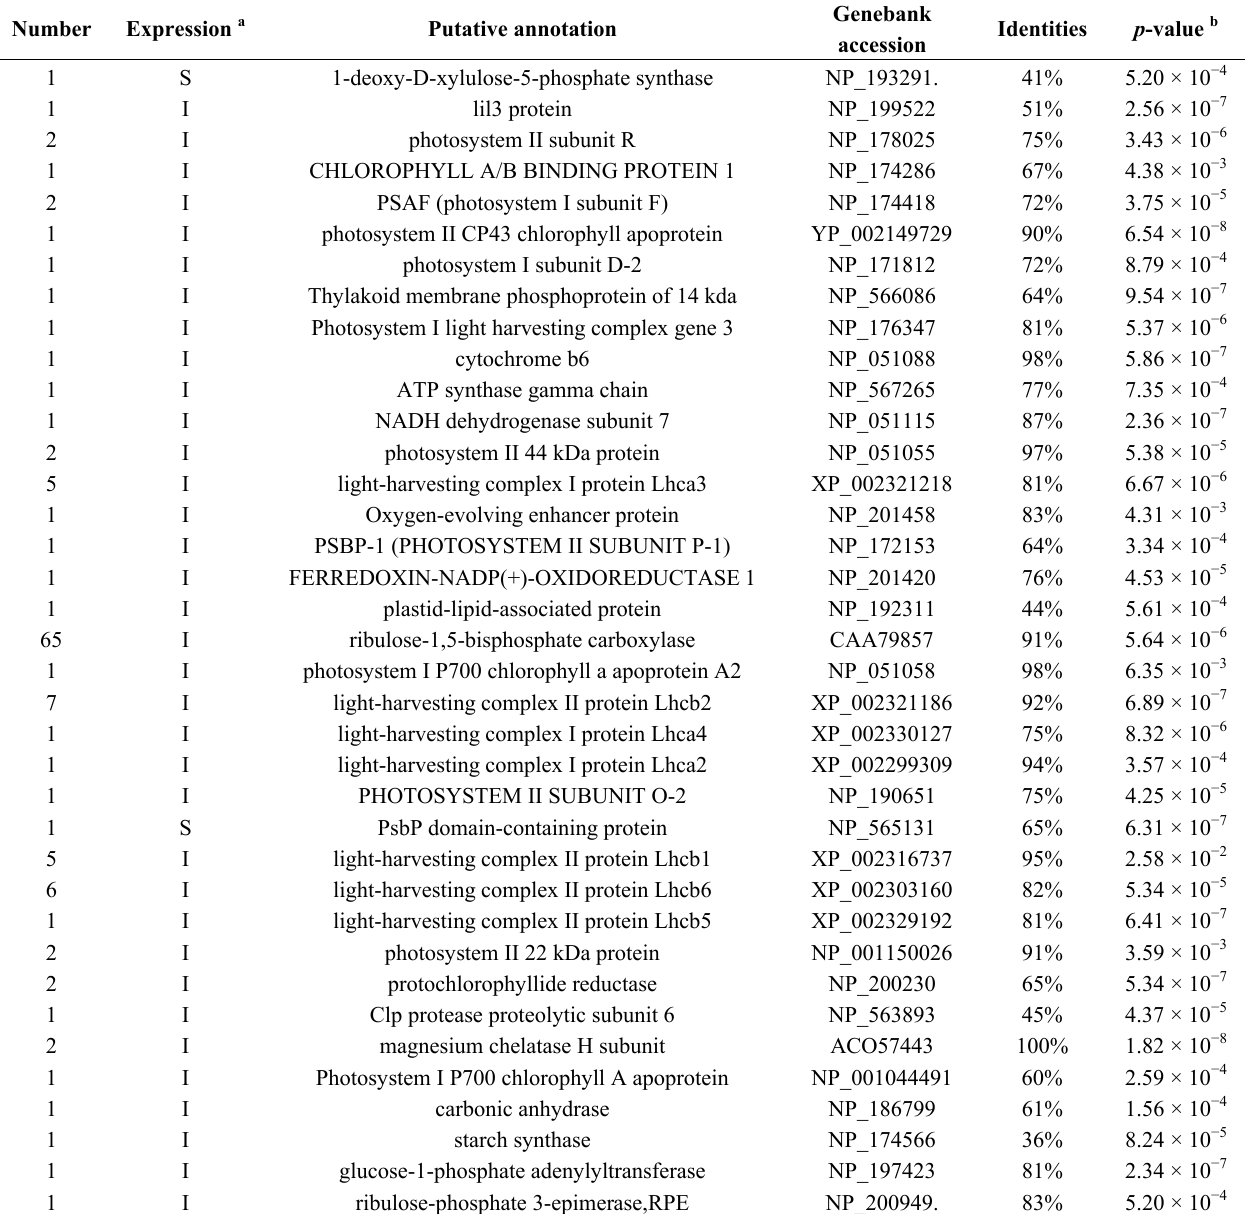
Table 4. Genes involved in photosynthesis in salt-stressed Malus zumi